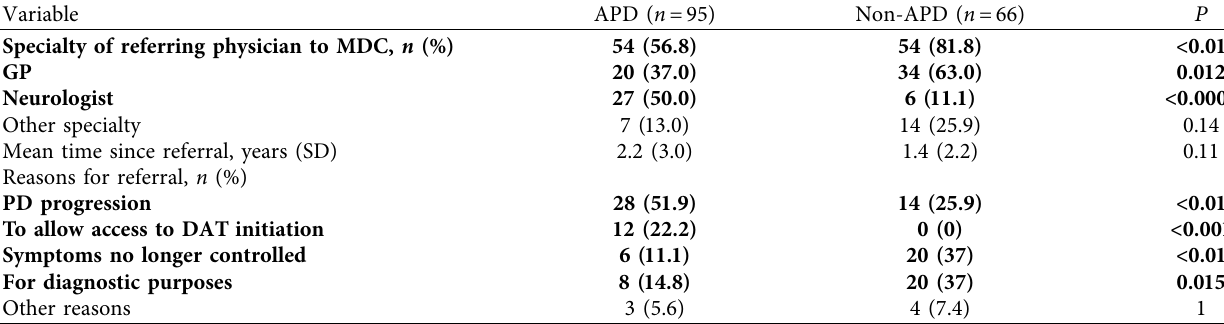
Table 3: Referral history to MDC. APD versus